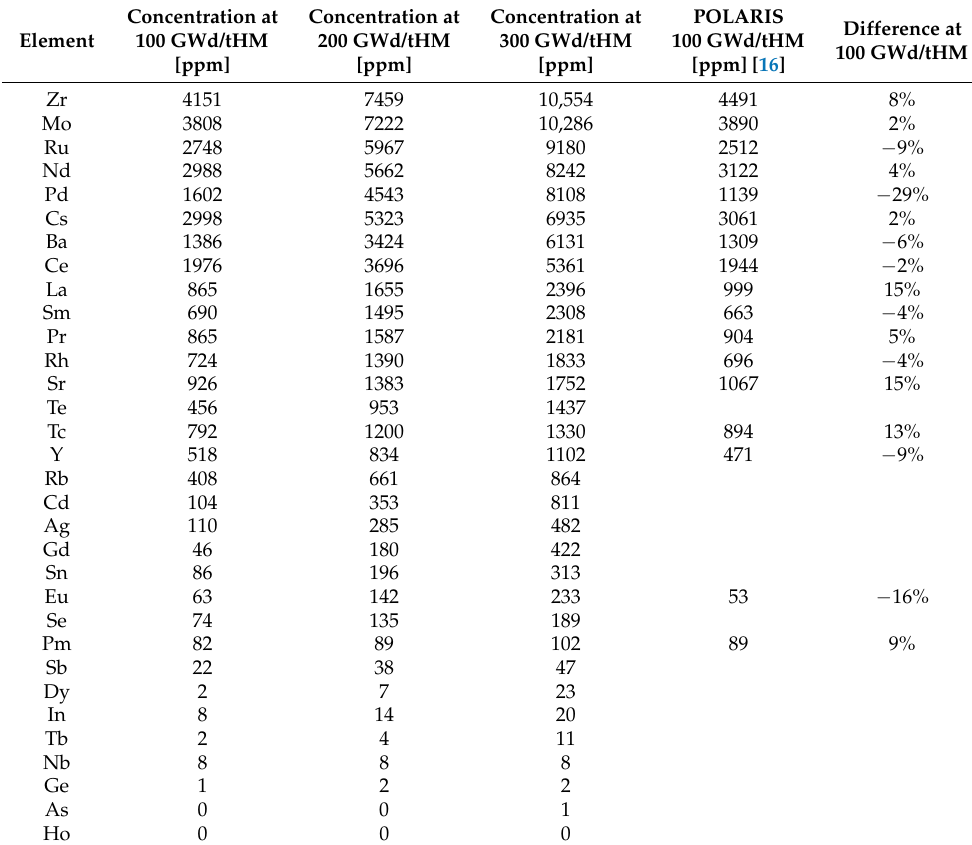
Table 1. Fission product elements followed through the HELIOS simulation with the concentrations appearing after different accumulated burnup states of the salt without clean-up and comparison of the results to POLARIS results published in [16].